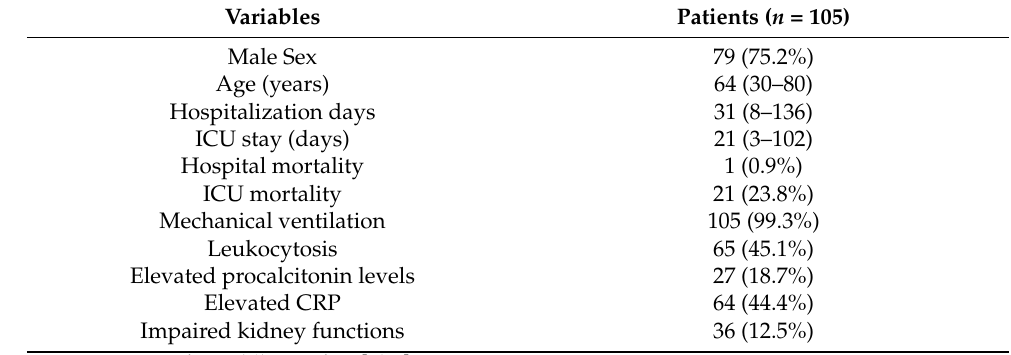
Table 1. Clinical characteristics of patients.